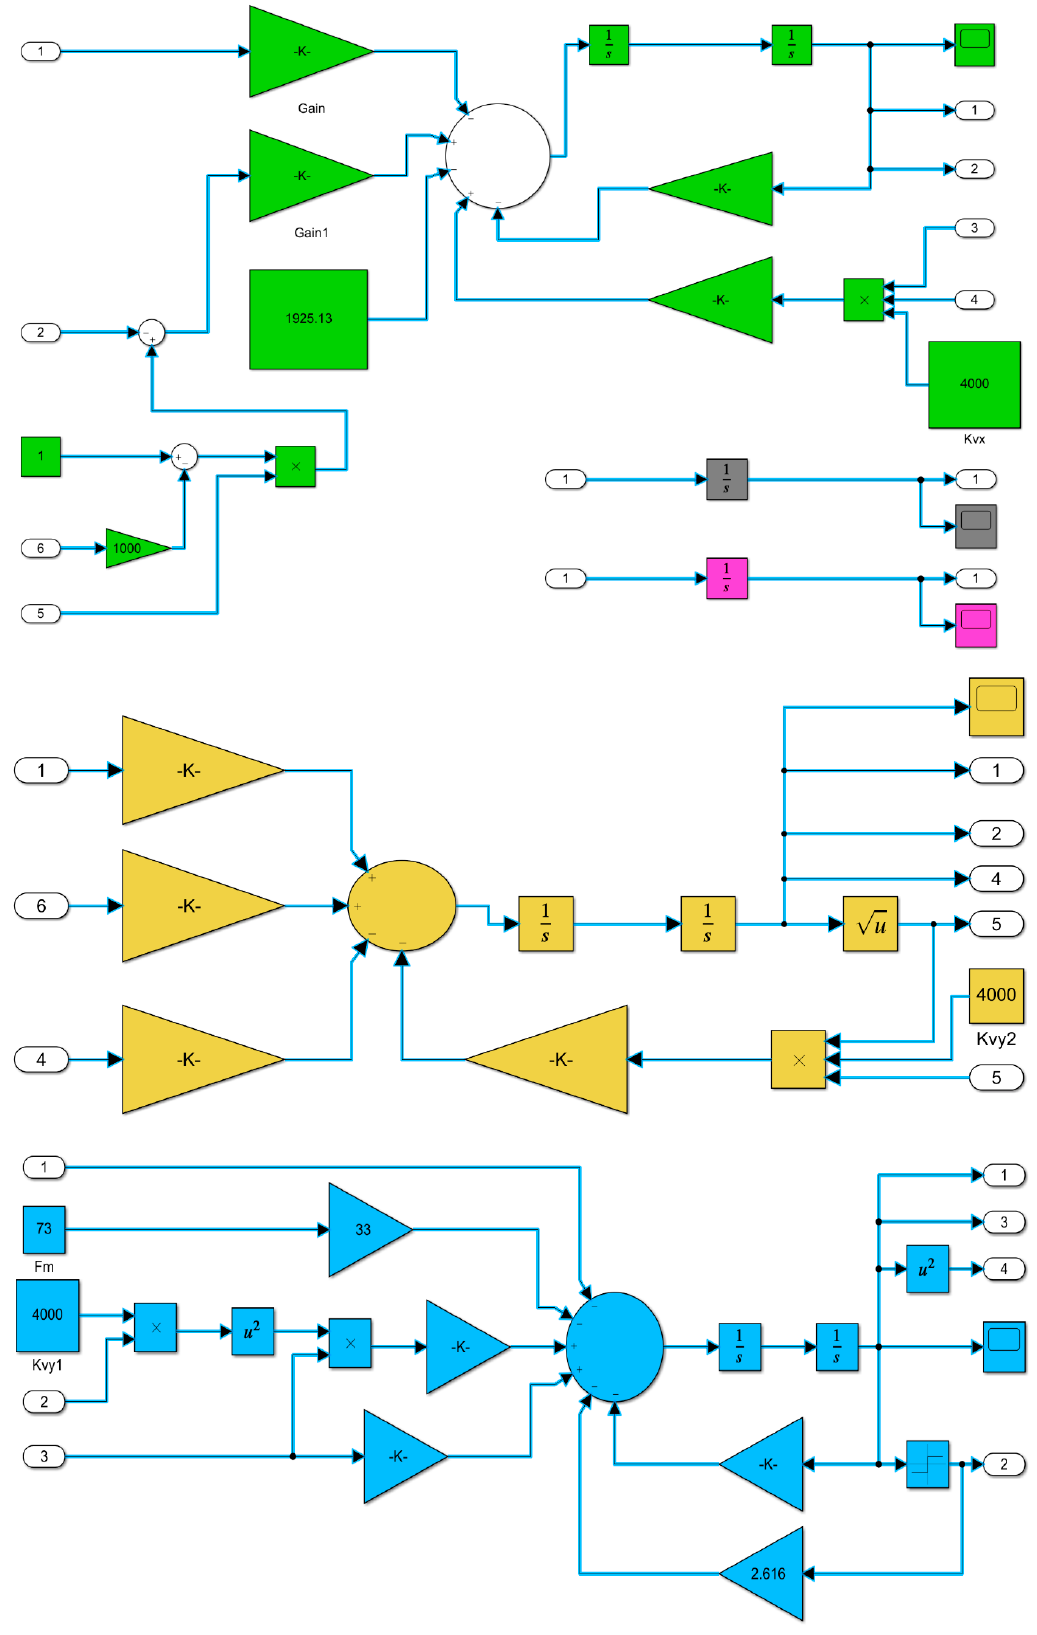
Figure A1. Model in Matlab. 1-6 describes inputs and outputs.